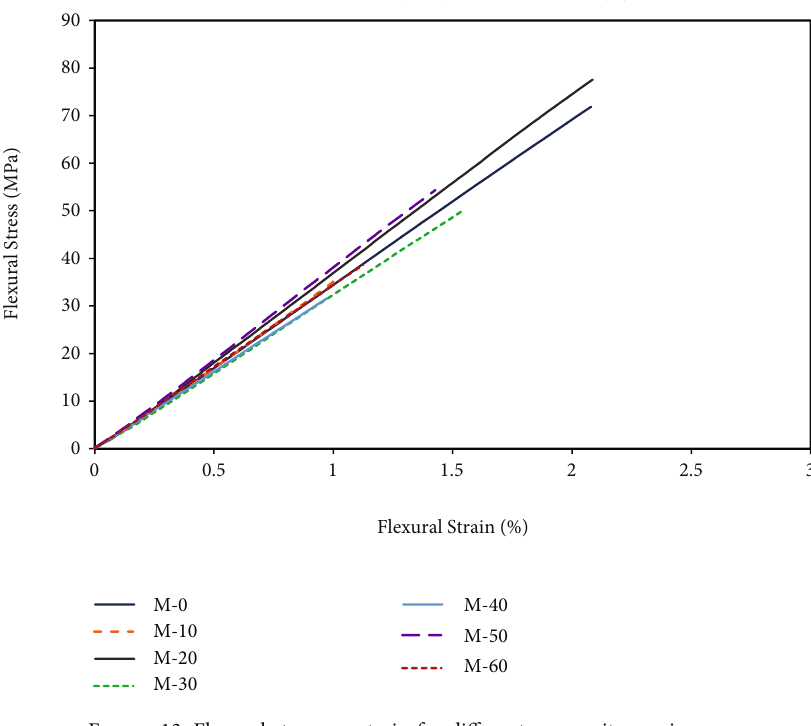
Figure 13: Flexural stress vs. strain for di ff erent composite specimens.